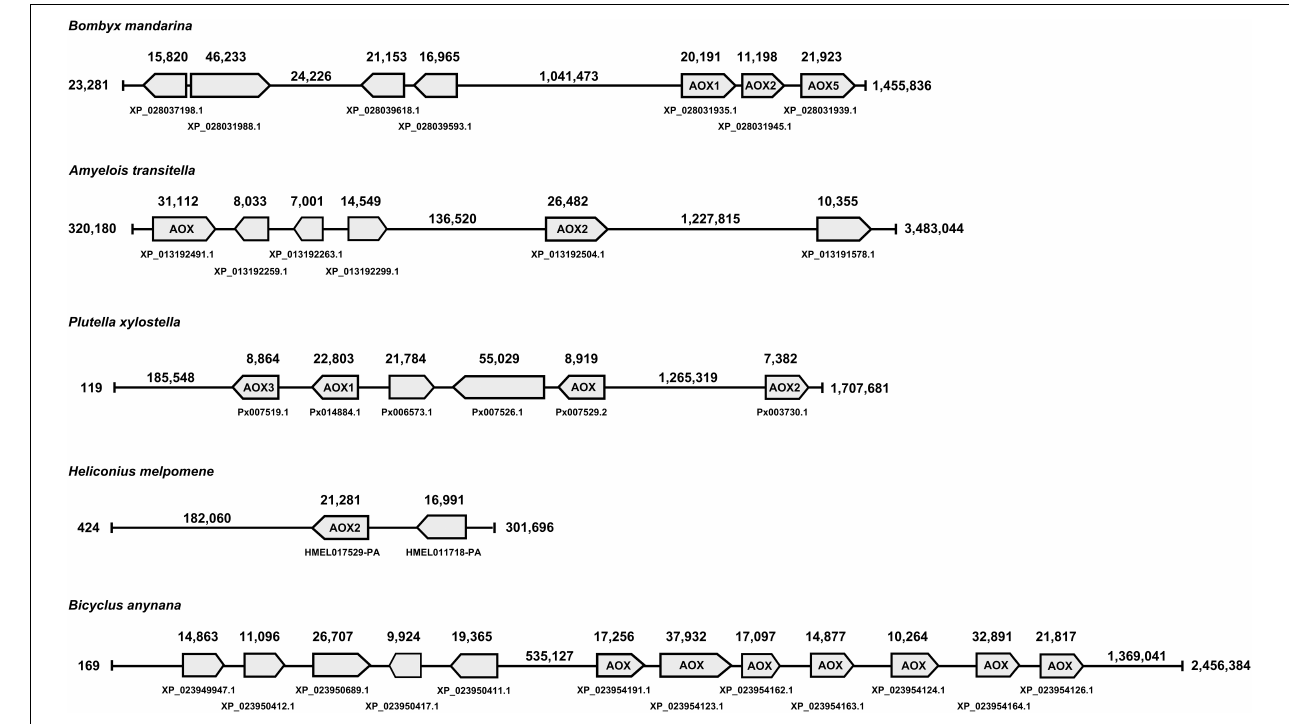
FIGURE 2 | Gene location analysis for AOXs identified from lepidopterans that use aldehydes as semiochemicals, such as moths B. mandarina , A. transitella , P. xylostella and butterflies H. melpomene and B. anynana .